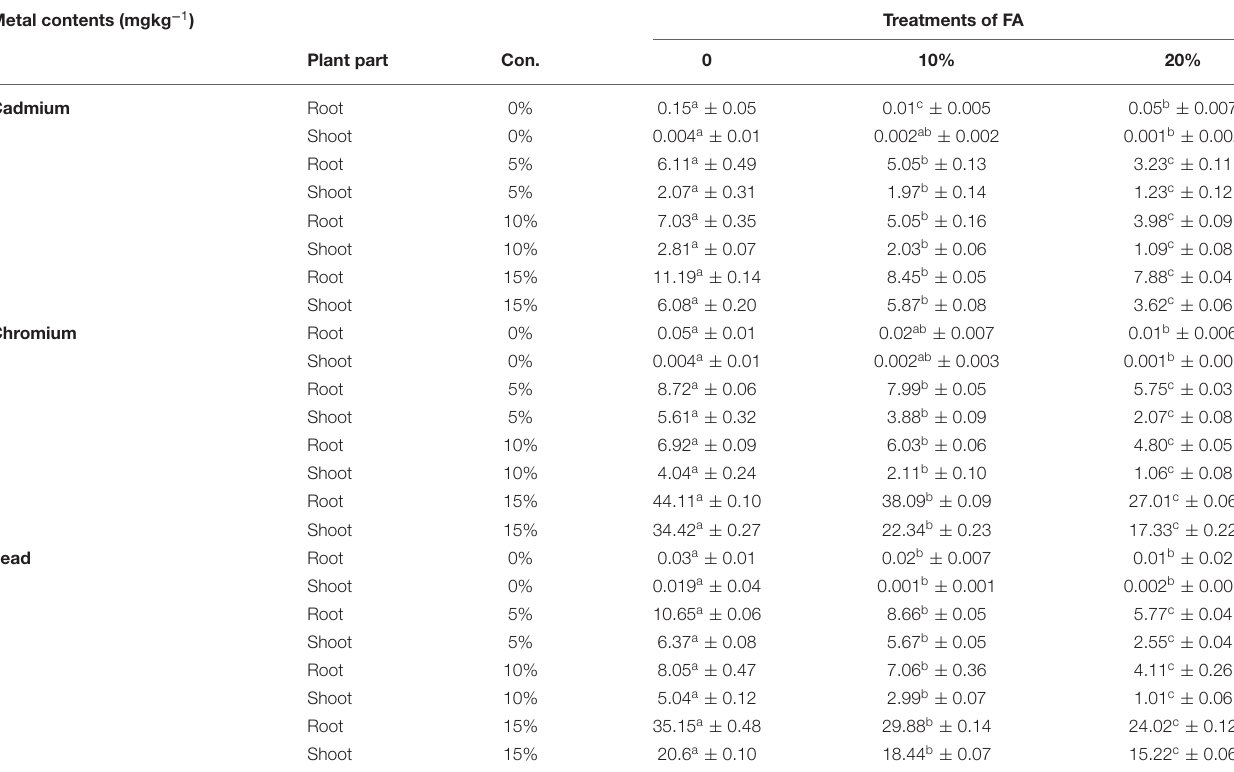
TABLE 4 | Determination of Cr, Cd, and Pb contents of B. napus plants grown at different concentrations of paper sludge after 90 days of the experiment. Metal contents (mgkg − 1